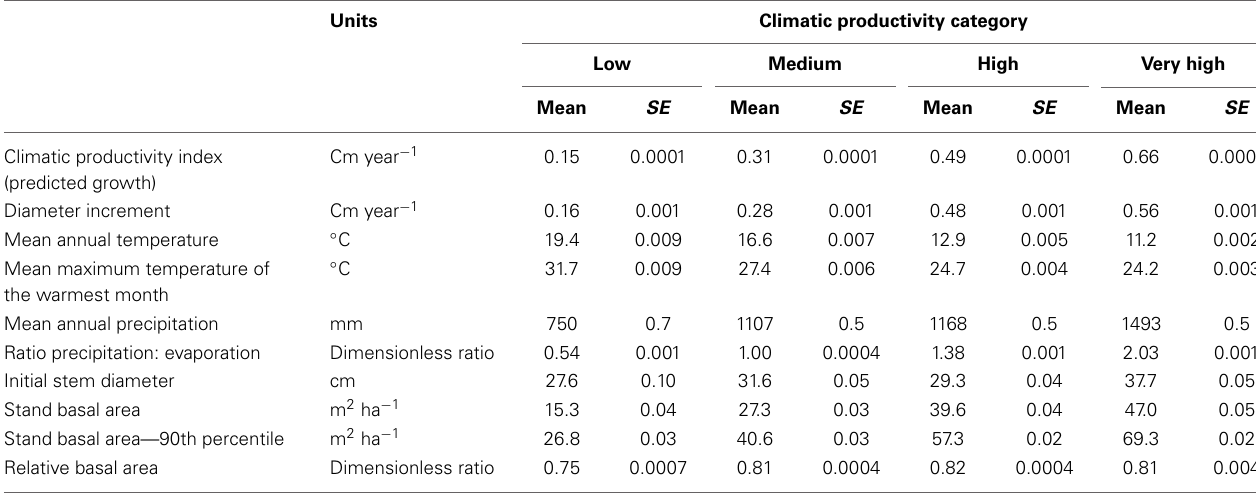
FIGURE 3 | Climatic productivity index as a function of (A) mean annual temperature and (B) the ratio of precipitation to evaporation. The index was based on a generalized additive model describing eucalypt growth (in cm year − 1 ) in relation to these Table 1 | Summary of climatic conditions, stand basal area, and tree size in the four Climatic Productivity Categories, defined according to growth rate predicted from mean annual temperature and the ratio of precipitation to